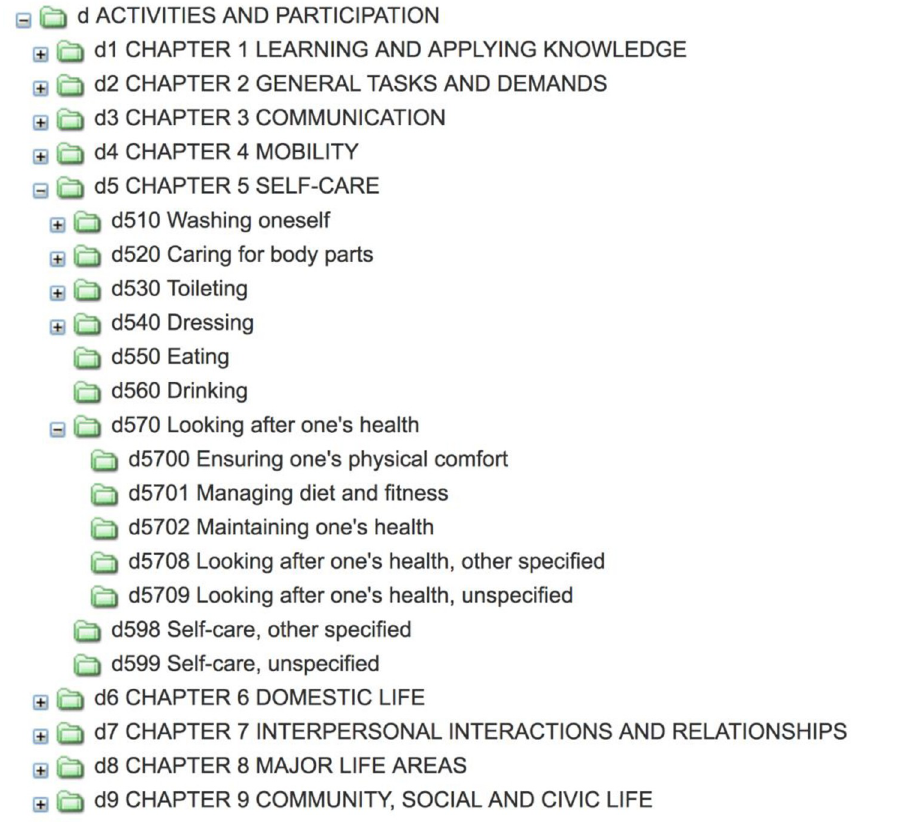
Fig 1. ICF category D with d570 expanded (http://apps.who.int/classifications/icfbrowser/).